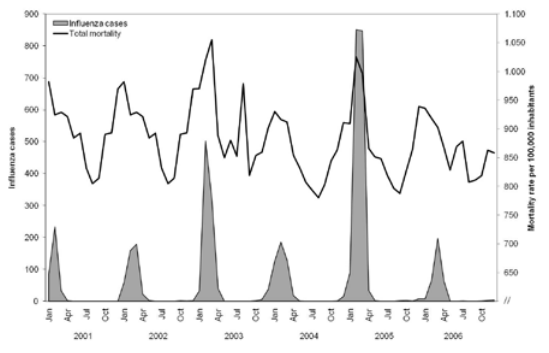
Figure 3. Influenza cases and total mortality in Baden- Wuerttemberg, Germany,